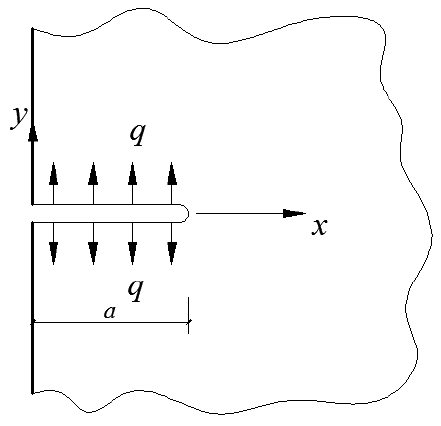
( c ) Figure 9. Crack propagation. ( a ) Crack propagation on specimen surface; ( b ) generalized strain distribution on specimen surface; ( c ) AE events location on specimen surface. 3.2.1. Double-Strain Criterion of Crack Propagation Comparing Figure 9a–c, it can be seen that frost-heave crack propagation is in accordance with